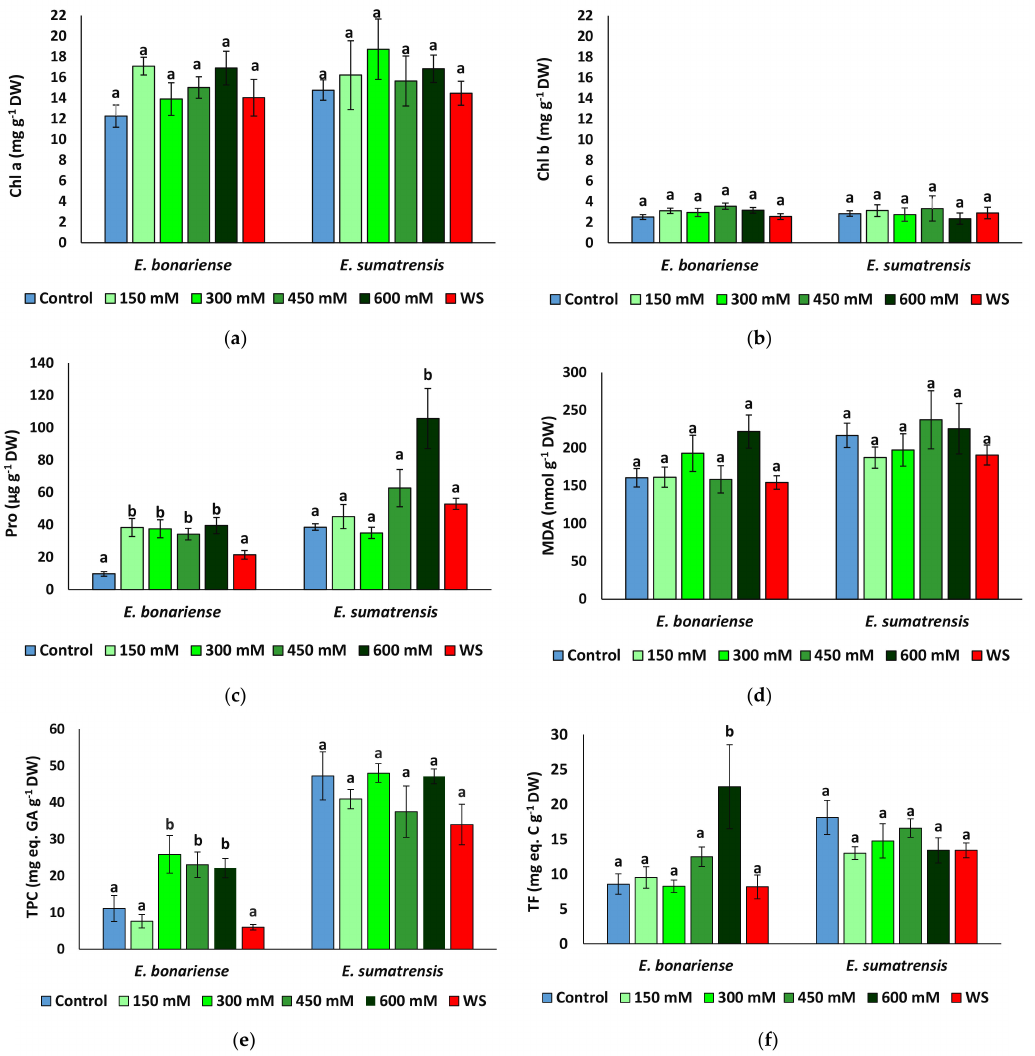
Figure 6. Concentrations of biochemical compounds analysed in the leaves of Erigeron bonariensis and E. sumatrensis plants after 1 month of treatment with the indicated NaCl concentrations or 1 month of water stress (WS) (mean ± SE, n = 7): ( a ) chlorophyll a (Chl a); ( b ) chlorophyll b (Chl b); ( c ) proline (Pro); ( d ) malondialdehyde (MDA); ( e ) total phenolic compounds (TFCs); ( f ) total flavonoids (TFs). Same letters indicate homogeneous groups between treatments for each species, according to the Tukey test ( α <